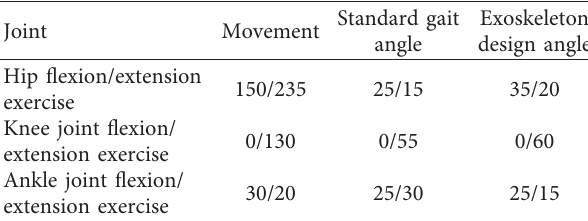
Table 2: Joint motion range of lower limb exoskeleton